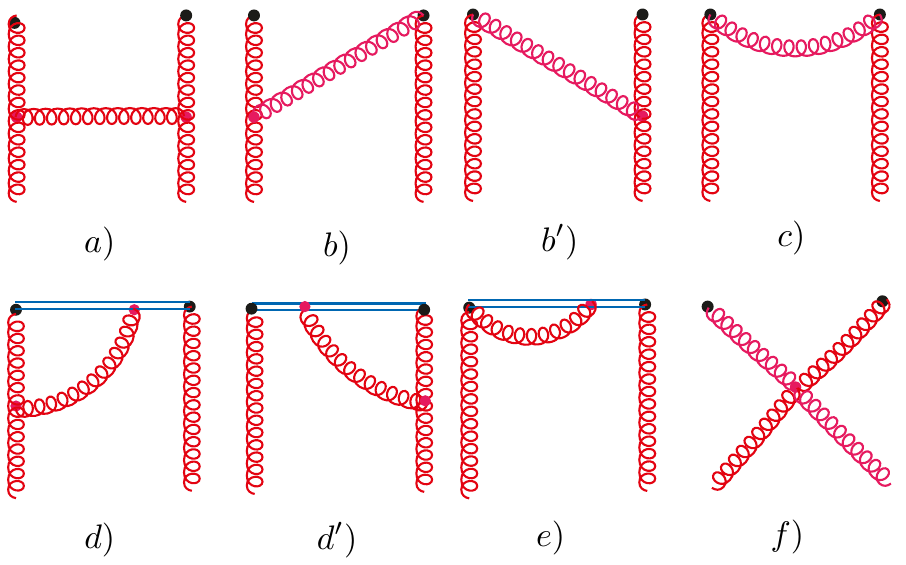
Figure 1 . “Real” diagrams (mirror diagram e 0 is not